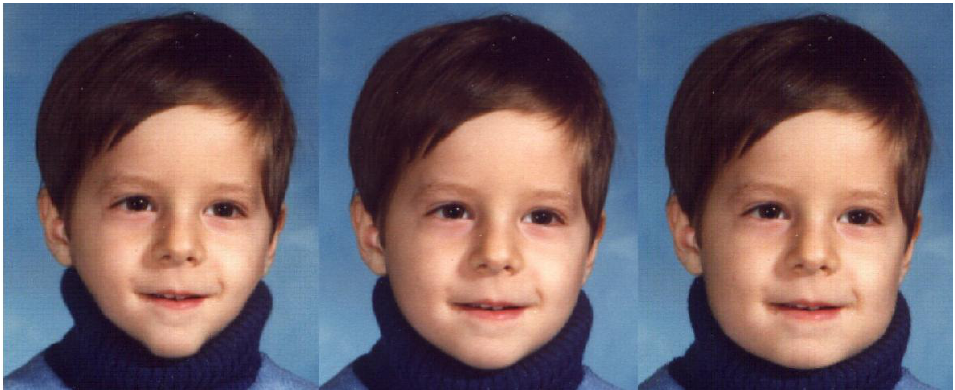
FIGURE 1 . Example of low, unaltered, and high body weight